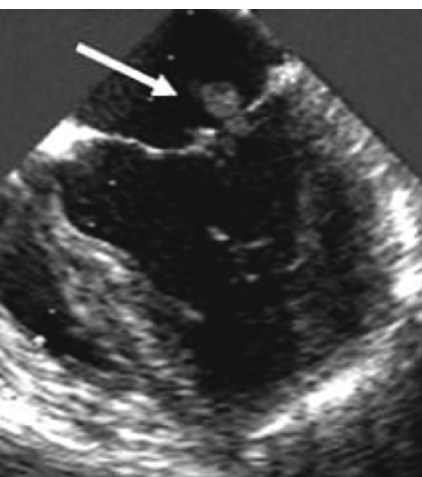
Figure 1: Trans esophageal echocardiogram showing Libman-sacks